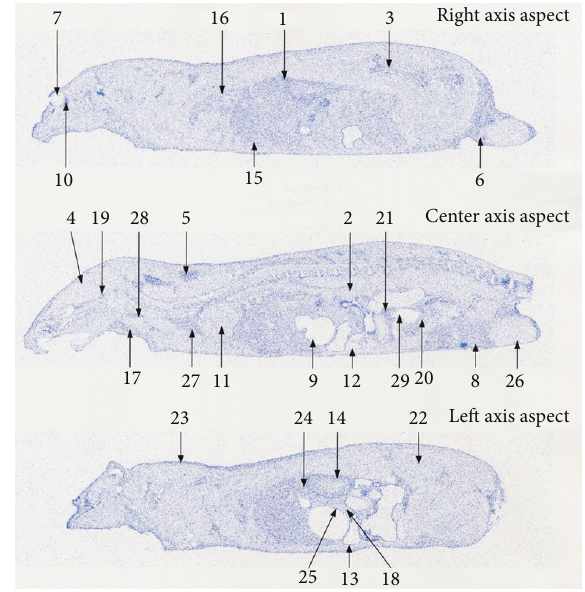
Figure 3: Whole body radioluminograms 24 hours after single oral administration of 14 C hyaluronic acid to a rat (dose: 25 mg/kg). (1) Adrenal gland. (2) Blood. (3) Bone marrow. (4) Brain. (5) Brown fat. (6) Epididymis. (7) Eyeball. (8) Fat. (9) Gastric contents. (10) Harderian gland. (11) Heart. (12) Intestinal contents. (13) Intestine. (14) Kidney. (15) Liver. (16) Lung. (17) Mandibular gland. (18) Pancreas. (19) Pituitary gland. (20) Prostate gland. (21) Seminal vesicle. (22) Skeletal muscle. (23) Skin. (24) Spleen. (25) Stomach. (26) Testes. (27) Thymus. (28) Thyroid gland. (29) Urine in bladder.